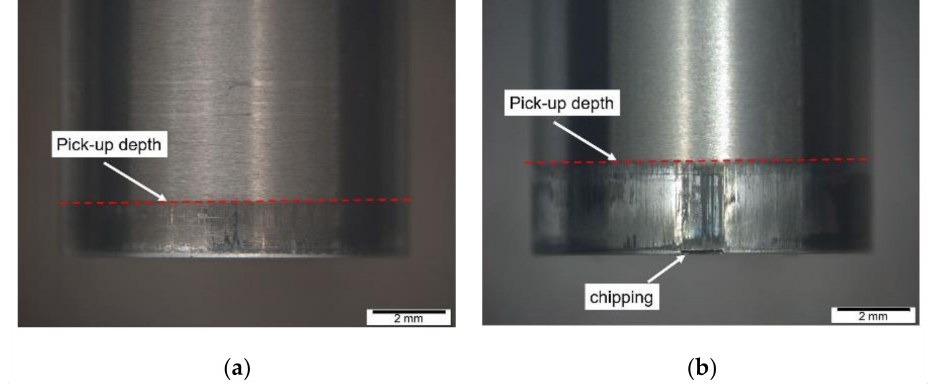
Figure 11. Worn punches after 100,000 strokes against CP1180HD: ( a ) VSC punch and ( b ) V8SC punch.